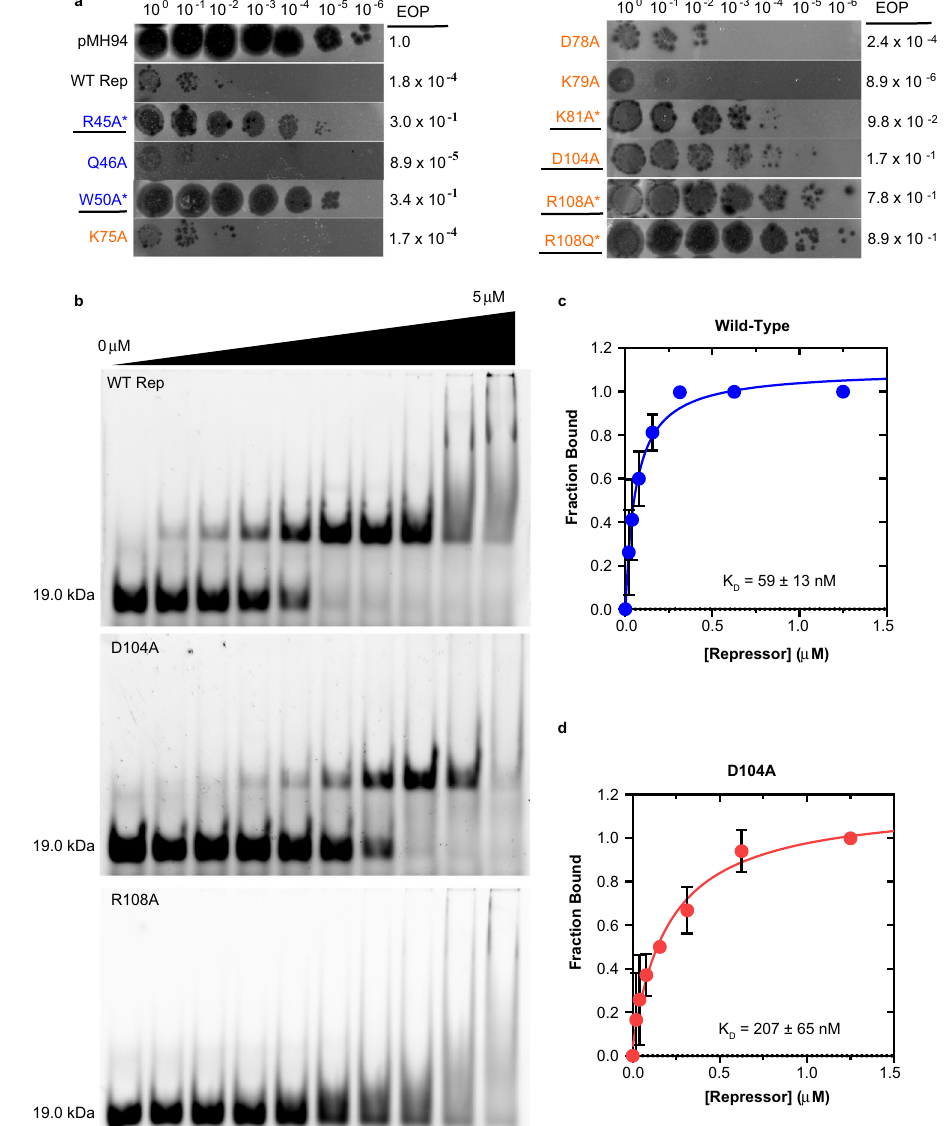
Fig. 4 Residues critical for repressor function. a TipsytheTRex virus was serially diluted and spotted onto top agar containing cells integrated with a single copy of the pMH94 empty vector, vector plus wild-type (WT) repressor and its endogenous promoter, or the indicated mutants. Spot titers and the ef fi ciency of virus plating (EOP) were calculated as compared to vector-only containing cells. Mutants tested are color-coded to indicate whether they are from the HTH (blue) or Stoperator (orange) domains. Results shown are representative of three independent experiments. b Mutants underlined in panel a were tested for their ability to bind DNA using electrophoretic mobility shift assays. For each gel, fl uorescein-labeled DNA was mixed with 0, 0.02, 0.04, 0.08, 0.16, 0.31, 0.63, 1.25, 2.5, or 5 μ M protein. The mass of free DNA in the absence of protein (19.0 kDa) is indicated for each gel. A titration of the wild- type repressor (WT Rep) shows a shift in band size indicative of protein:DNA complex formation. The smearing present in the last two lanes represent non-speci fi c complex formation present at high protein concentrations. While the D104A mutant retained the ability to bind DNA, the R108A mutant has lost the ability to form a speci fi c complex with the DNA substrate. All mutants with an asterisk in panel a showed DNA-binding behavior similar to R108A (see Supplementary Fig. 6). This experiment was performed in three independent experiments, with similar results. c , d Both the wild-type (panel c , blue trace) and D104A (panel d , red trace) repressors bind the DNA ligand, with the D104A mutant displaying an ∼ 3.5-fold weaker DNA-binding af fi nity as compared to wild-type. Plotted are the mean and standard deviation values calculated from three independent experiments. Source data are provided in the Source Data fi